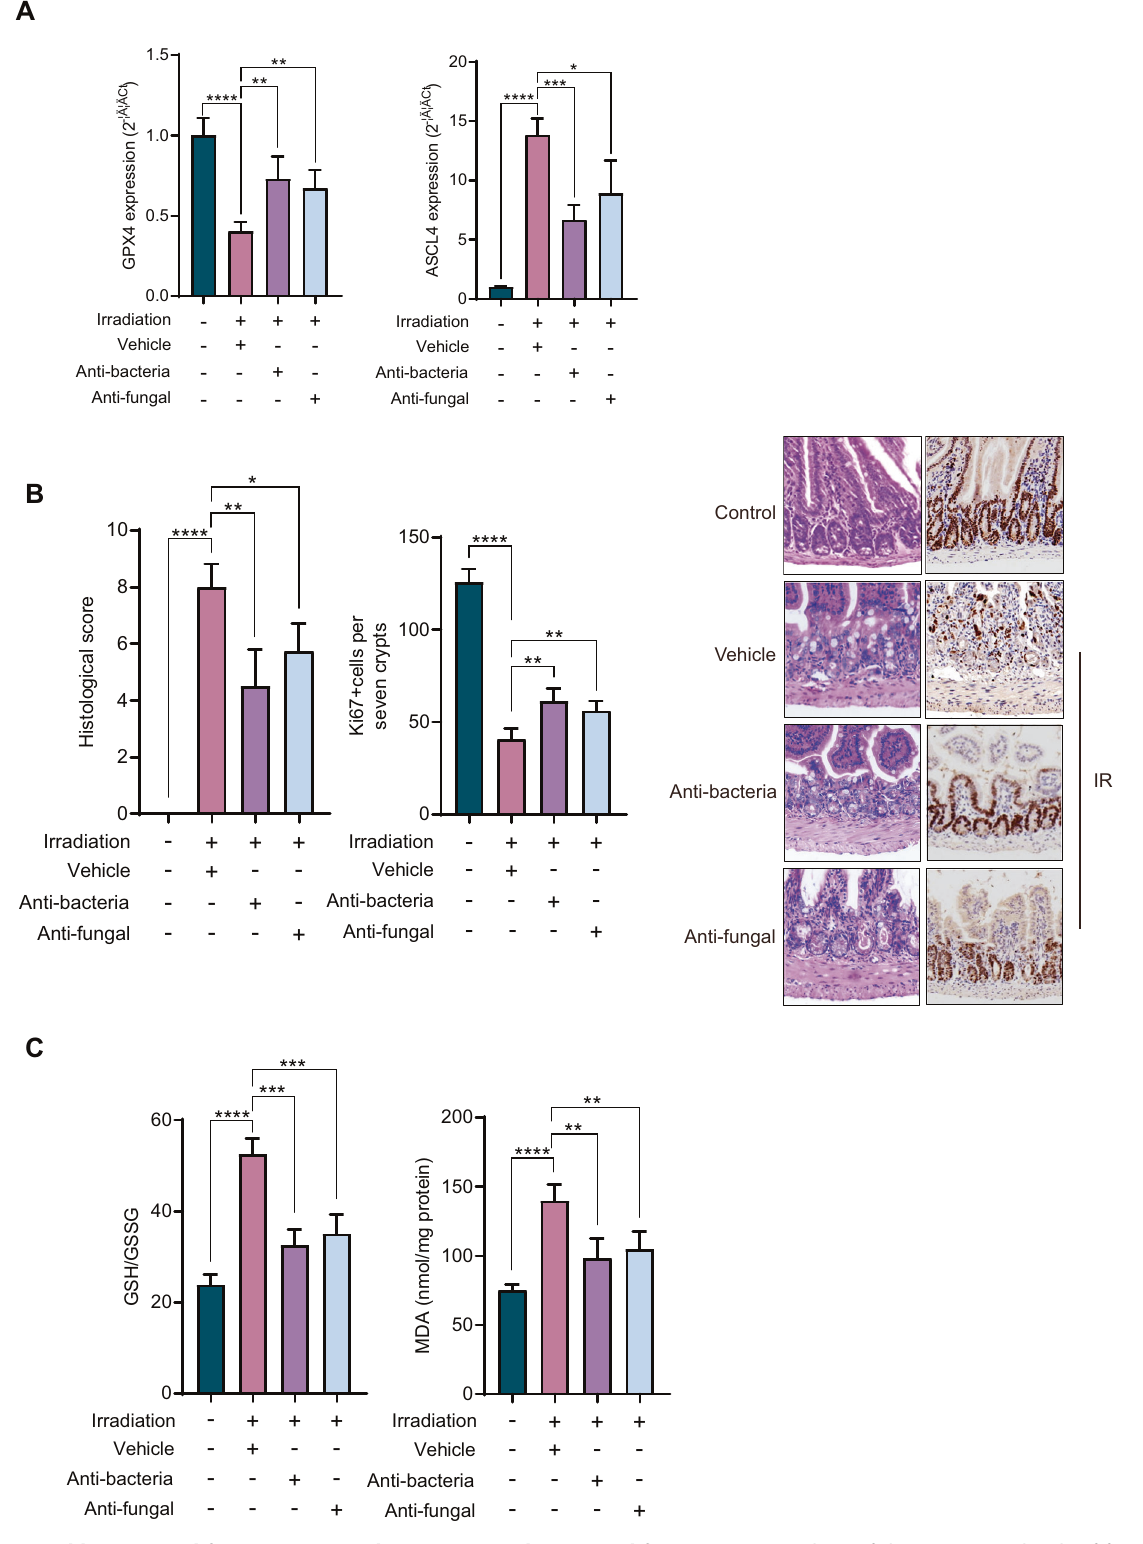
Fig. 4 Intestinal bacteria and fungi promote radiation intestinal injury and ferroptosis. A Analysis of the expression levels of ferroptosis- related genes GPX4 and ACSL4 in intestinal tissues of mice in control, vehicle, antibacterial and antifungal. B Histological scores of intestinal tissues of mice after IR. Ki67 + cells were counted in seven crypts. Representative images of the H&E staining and Ki67 staining of the intestine from control, vehicle, antibacterial and antifungal. C Analysis of GSH/GSSG and MDA in intestinal control, vehicle, antibacterial, and antifungal of mice. P values are derived from permutation test, two-sided Student ’ s t test. * p < 0.05, ** p < 0.01, *** p < 0.001, **** p <